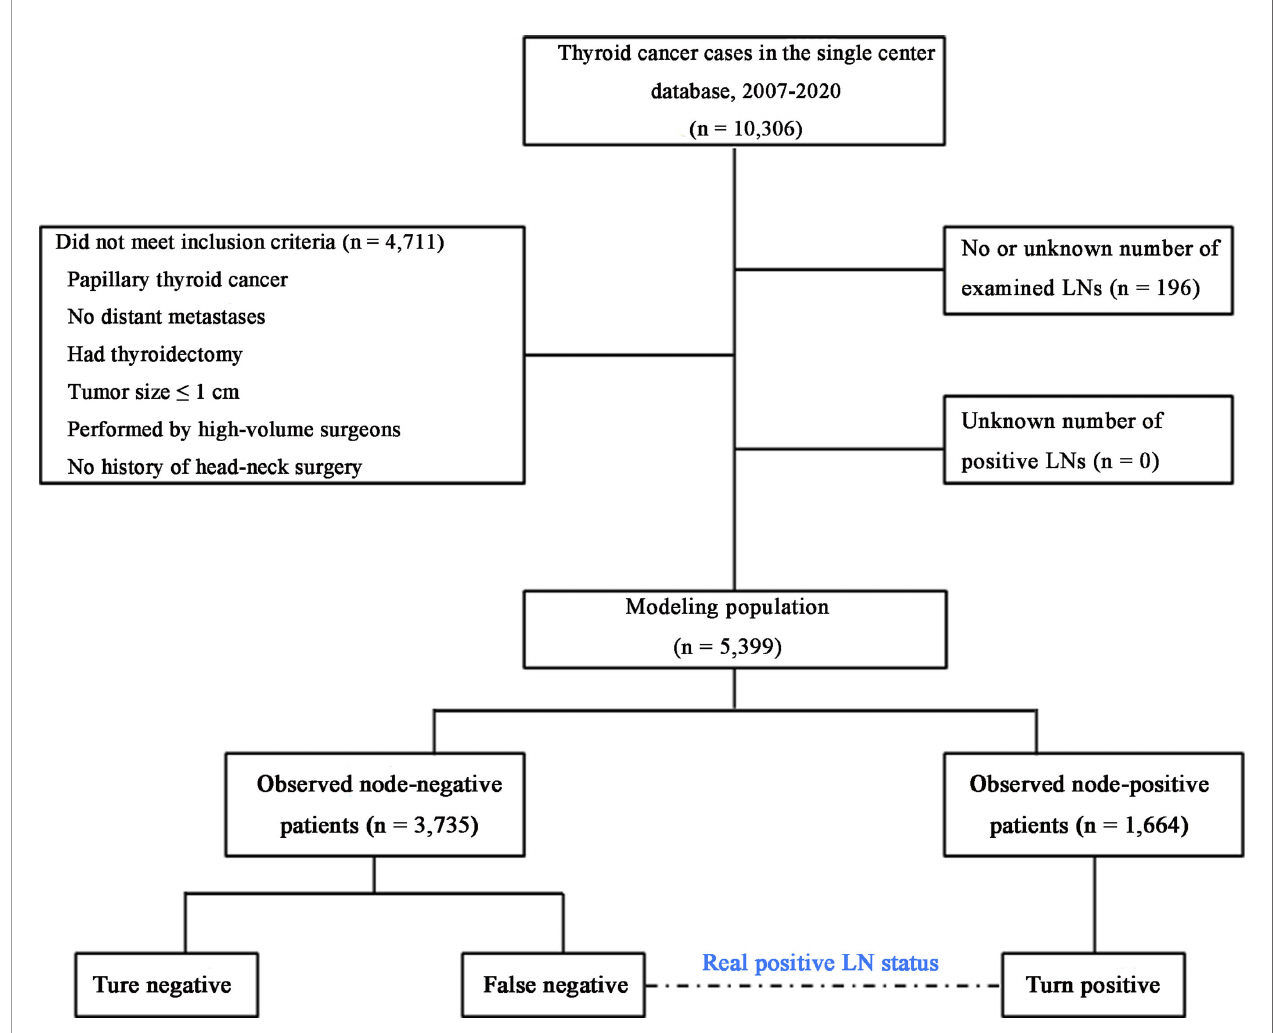
FIGURE 1 | Flowchart of the modeling patient cohort. The patients were classi fi ed into three categories. LNs, lymph